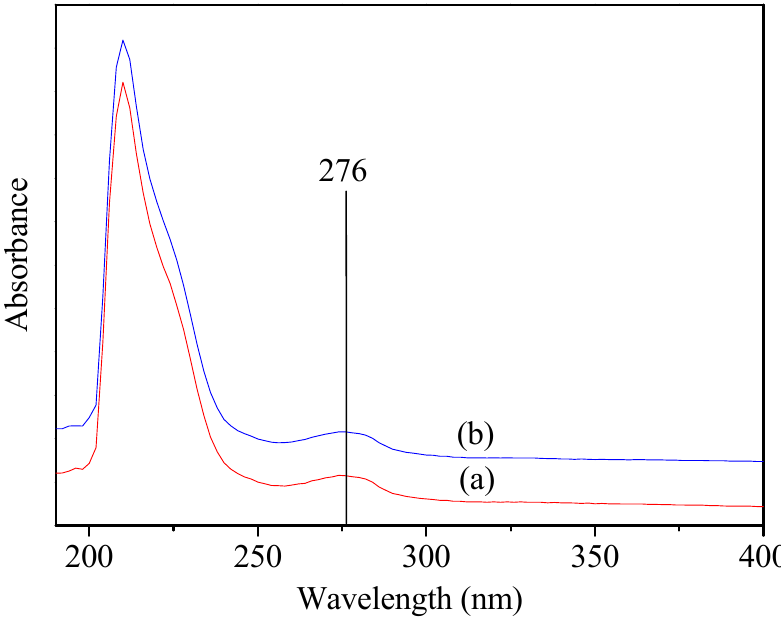
Figure 6. UV-Vis spectra of ( a ) SF and ( b ) SSF.